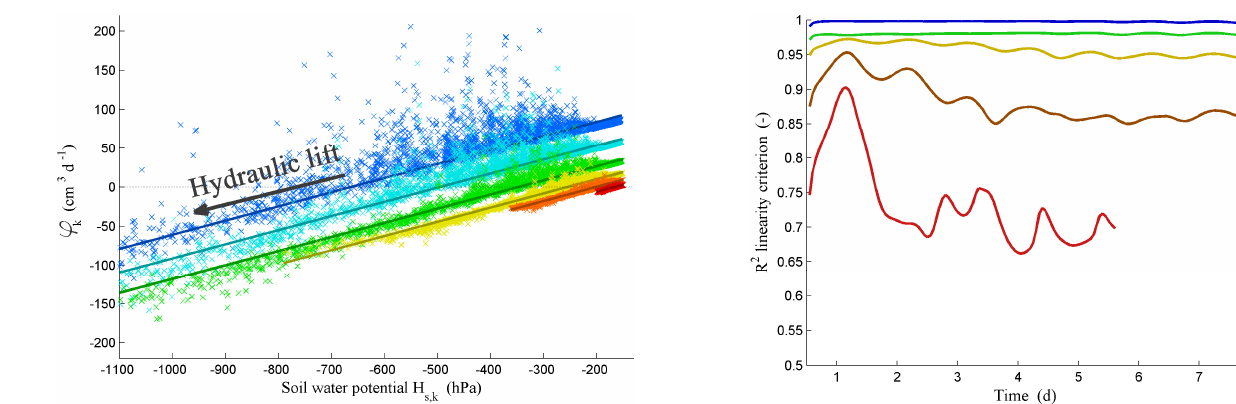
Fig. 8. Coefficient of determination R 2 of the ϕ k versus H s, k plots for different root axial conductance levels of magnitude (reference Figure 8. Coefficient of determination R 2 of the j k versus H s,k plots for different root axial 3 multiplied by 100 (blue), by 10 (green), by 1 (yellow), by 0.1 conductance levels of magnitude (reference multiplied by 100 (blue), by 10 (green), by 1 4 (brown), by 0.01 (red)) during the “Equil” (yellow), by 0.1 (brown), by 0.01 (red)) during the “Equil” scenario. 5